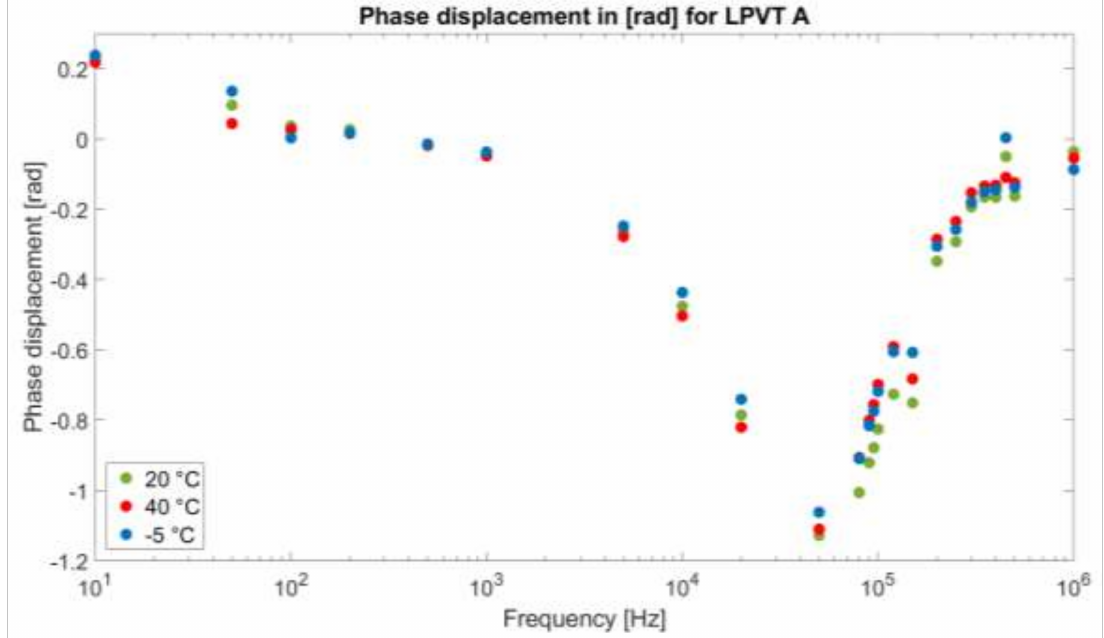
(cid:0) (cid:1) V p expressed in radians for LPVT A as a function of the frequency f at